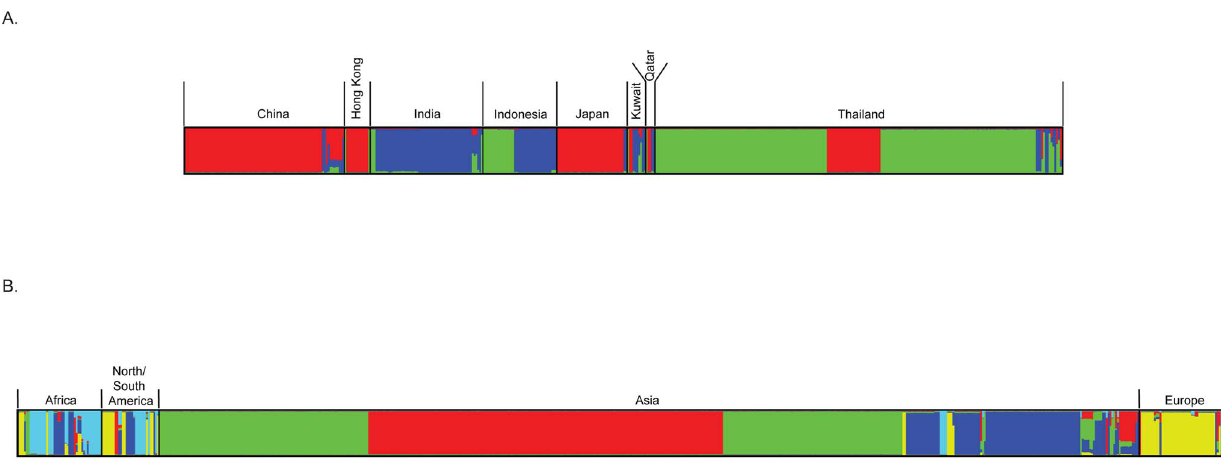
Figure 5. Population structure analysis among Asian C.neoformans var. grubii isolates obtained with the program STRUCTURE. (A) Comparing isolates from different countries and (B) global C . neoformans var. grubii isolates (data from http://mlst.mycologylab.org). The population groups are indicated by different colors. Each bar represents the individual isolates. Mixed color bar represents to share haplotypes in the individual isolate.